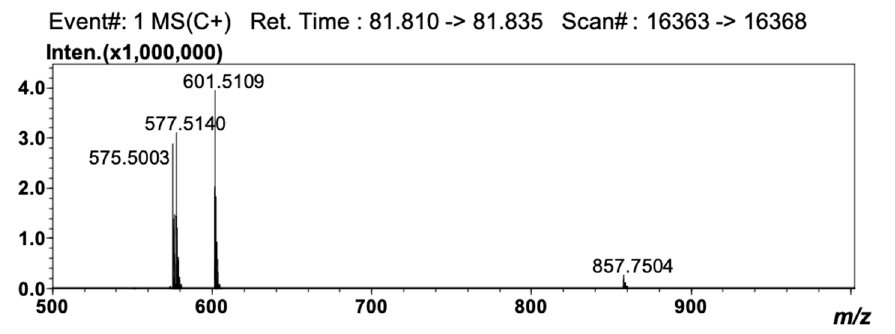
Figure 3. APCI-MS spectrum obtained for the peak of OLP.